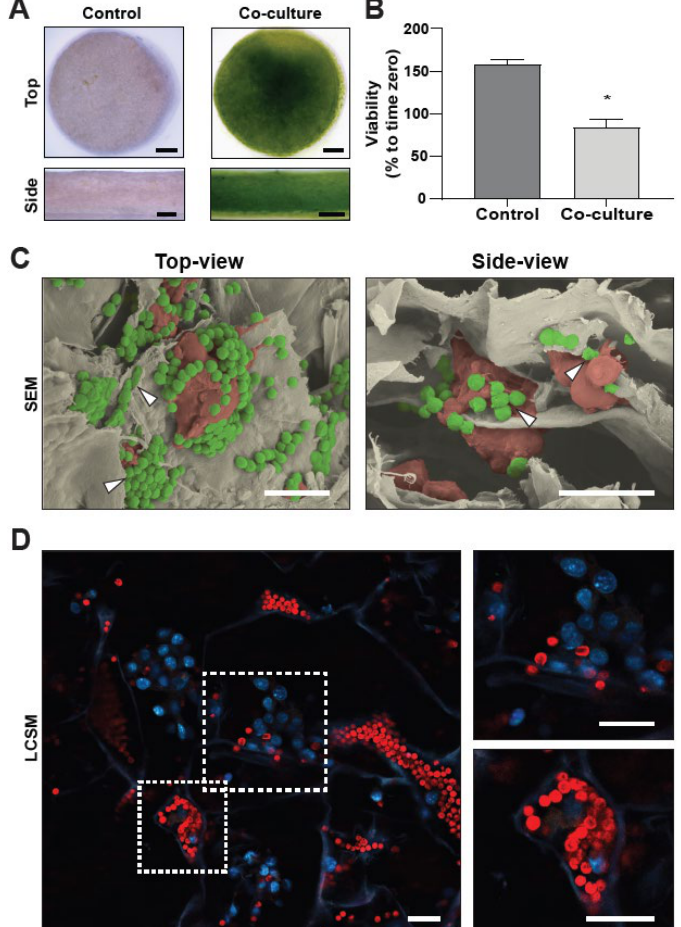
Figure 6. Morphological analysis of a photosynthetic 3D tumor model. C32 cells were seeded in a collagen-GAG scaffold and cultured for 48 h, with microalgae subsequently added. Overview images of the scaffolds show a generally homogeneous distribution of the microalgae ( A ). MTT analysis shows significantly lower metabolic activity in co-cultured scaffolds compared to control scaffolds ( B ). SEM images of 2-h co-cultured scaffolds show tumor cells in direct contact with microalgae ( C ). The top-view arrowheads ( C , left ) show microalgae in between collagen sheets, while side-view arrowheads ( C , right ) indicate microalgae interacting with cancer cells. Detailed LCSM images of 2-h co-cultured matrices ( D ) show direct physical contact between C32 cells (DAPI/blue) and microalgae (chlorophyll/red) ( D , left ). Right panels show magnifications of the indicated sections on the left panel. All assays were performed in at least three independent experiments and data are presented as average + SE. Scale bars represent 1 mm for ( A ), 20 µm for ( C ), and 50 µm for ( D ). p ≤ 0.05 was considered as significant using a Mann–Whitney test. * = p ≤ 0.05